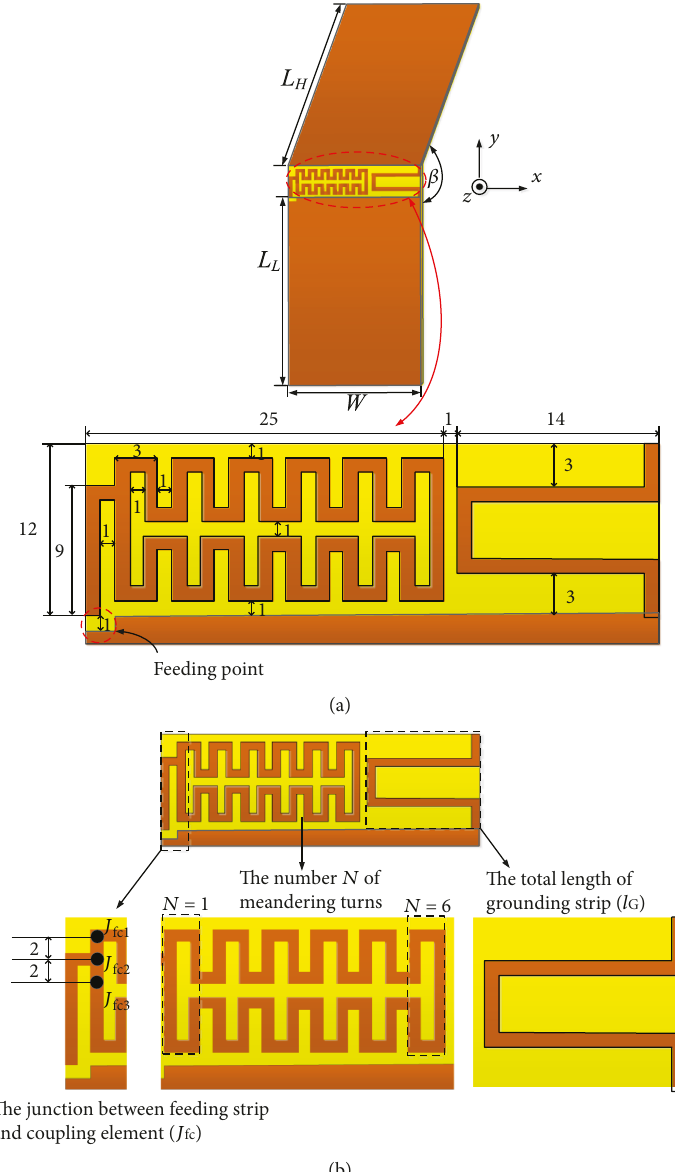
Figure 2: The geometry of the proposed meander line antenna (MLA) without MD (not to scale): (a) the dimensions and (b) the varied parameters ( J , N , and l ) for the optimal impedance fc G